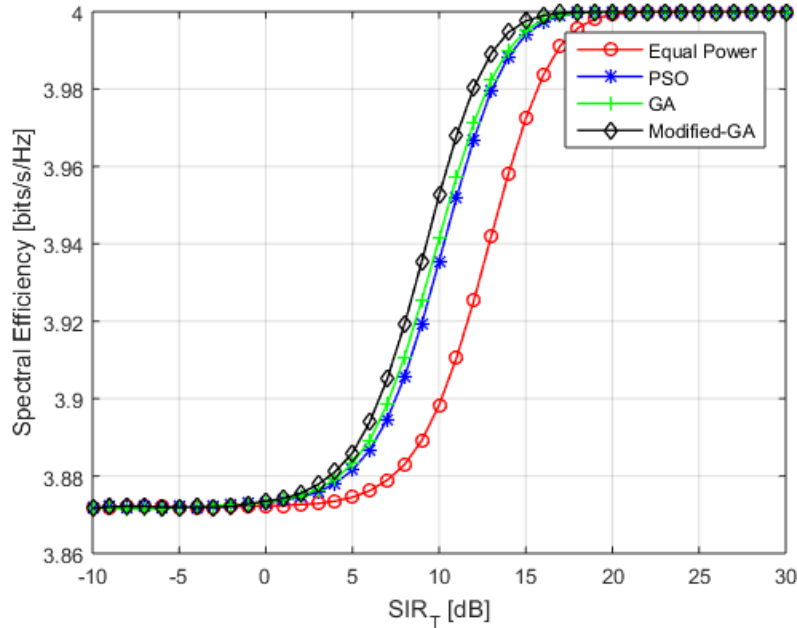
Figure 12. Spectral efficiency with respect to SIR T for different power optimization